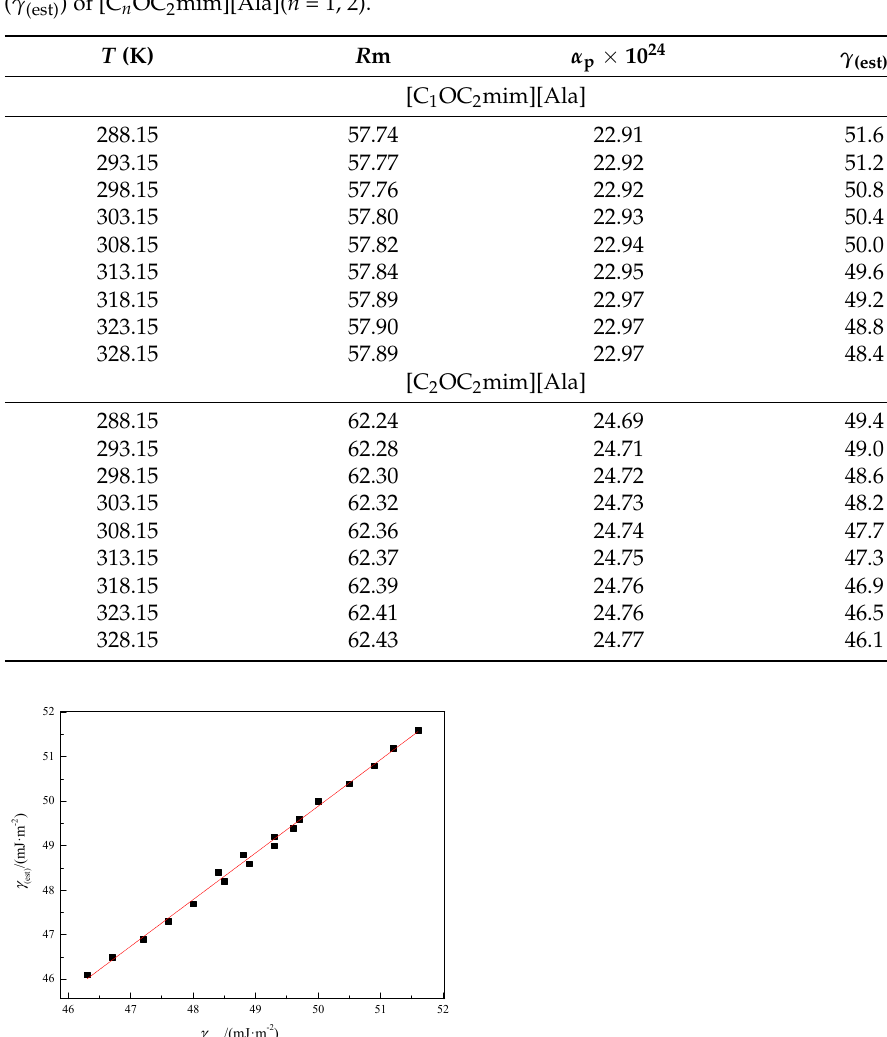
Figure 3. Plot of surface tension γ (est) against γ (exp) for [C n OC 2 mim][Ala]( n = 1,2). γ (est) =1.0581 γ (exp) − 2.9851; r 2 = 0.995; sd = 0.11.